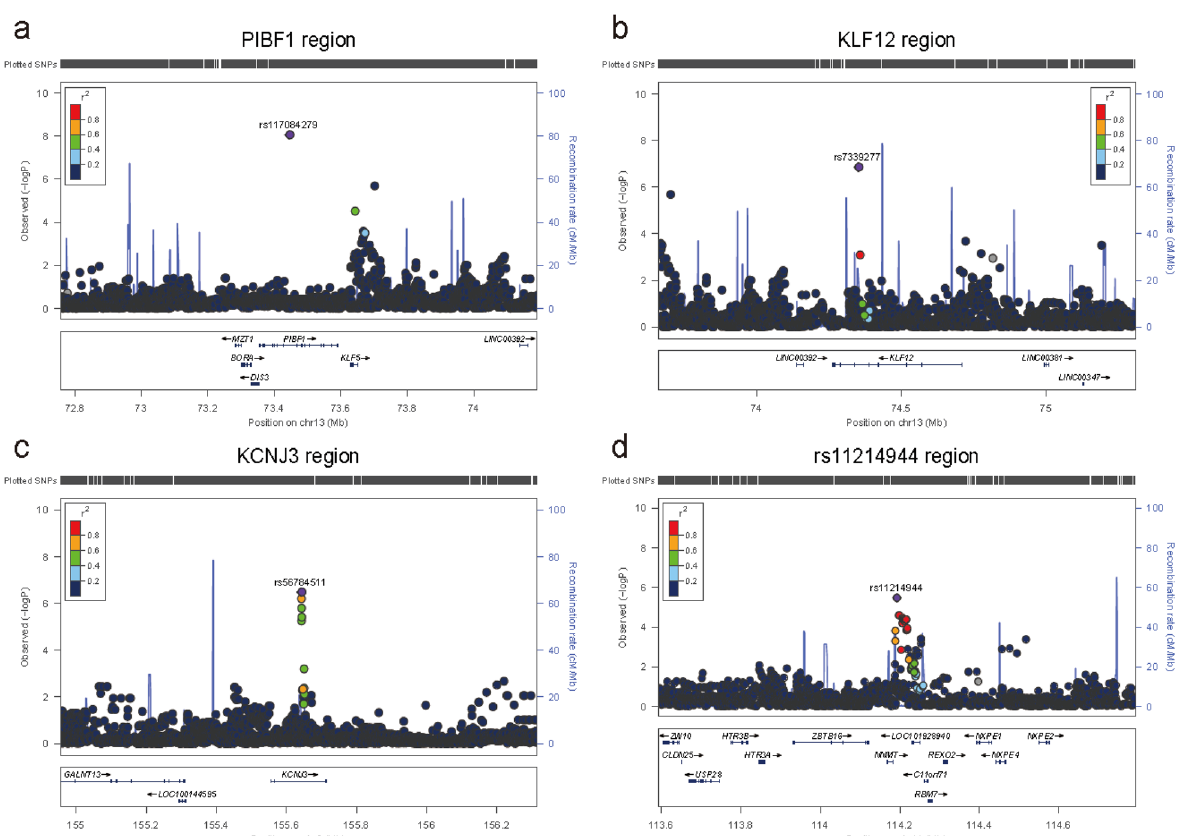
Figure 2. Regional plot for top SNPs in all subjects. Regional plot for ± 600 kb from top SNPs on PIBF1 ( a ), KLF12 ( b ), KCNJ3 ( c ) and rs11214944 ( d ) in total patient main